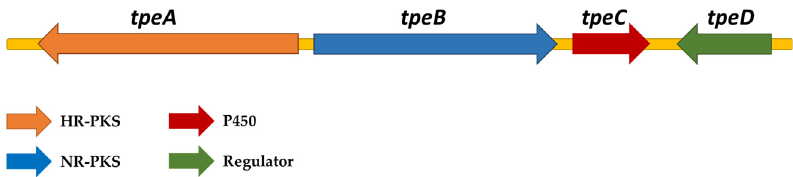
Figure 3. The putative biosynthetic gene cluster of the T. stipitatus polyesters encodes a highly reducing polyketide synthase (HR-PKS), a nonreducing polyketide synthase (NR-PKS), a cytochrome P450 oxygenase and a regulator protein.